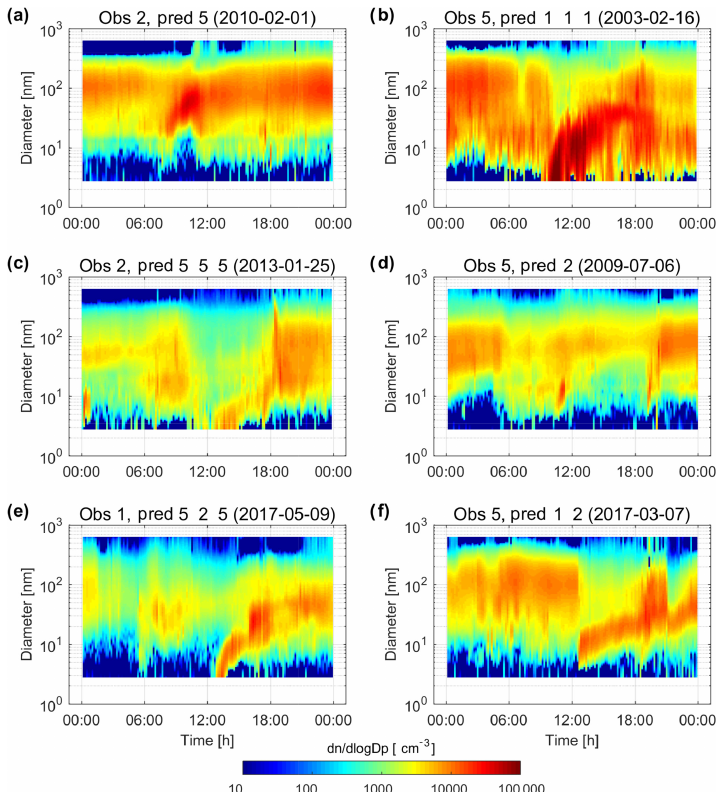
Figure 5. Examples of particle size distributions for different days when visually categorized clear event days (classes 1 and 2) are classified nonevent days by CNN classification or vice versa. In title, numbers after Obs and Pred show NPF event classes determined with visual and CNN-based classification, respectively (date of measurement in brackets). Several event class numbers in Pred cases are results from different calculation runs. The first row (a, b) contains examples of human-made misclassifications, the second row (c, d) CNN misclassifications and the third row (e, f) ambiguous situations (low particle concentrations and change in air masses during the day, respectively). CNN classification is from Image Set 1 with a training–testing ratio of 80% /